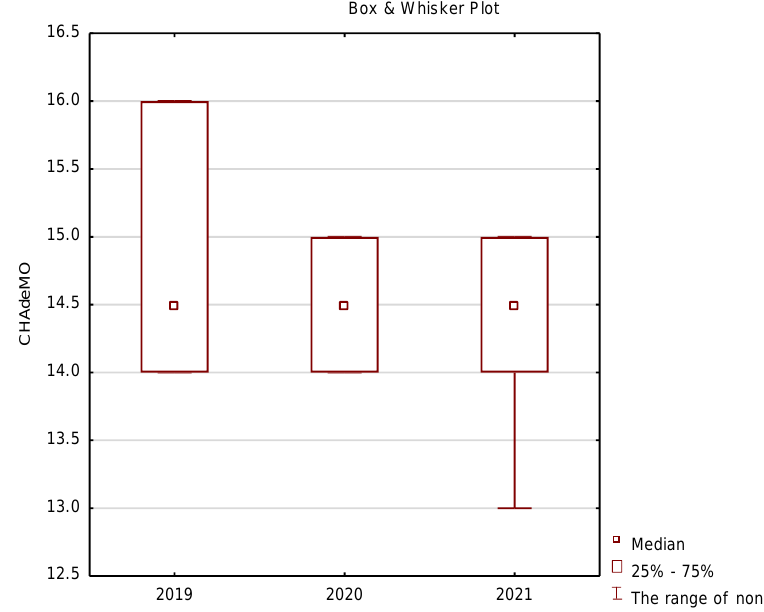
Figure 13. Box plots for the analysis of vehicle charging method — CHAdeMO.